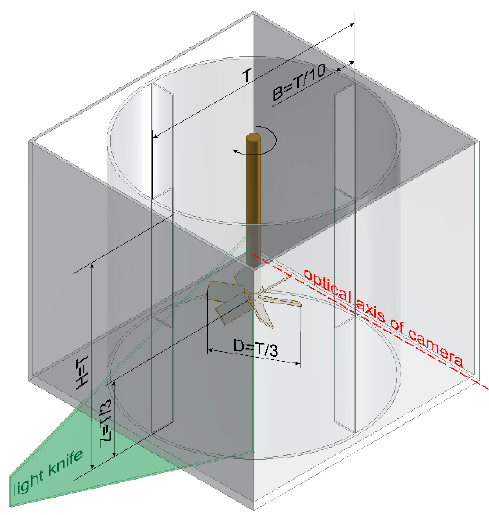
Figure 5. Position of the light knife during the measurement of the components of radial and axial velocity.